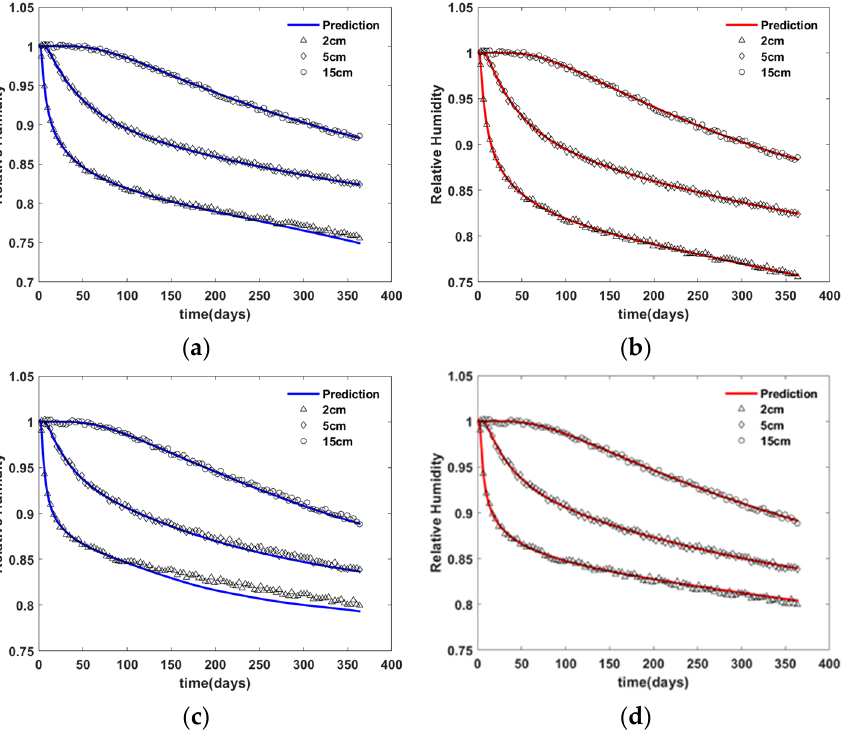
Figure 13. Comparison of virtual experimental data with the predicted data based on ANN N1—( a ) material M1 and 90 day observation, ( b ) material M1 and 180 day observation, ( c ) material M2 and 90 day observation, and ( d ) material M2 and 180 day observation.